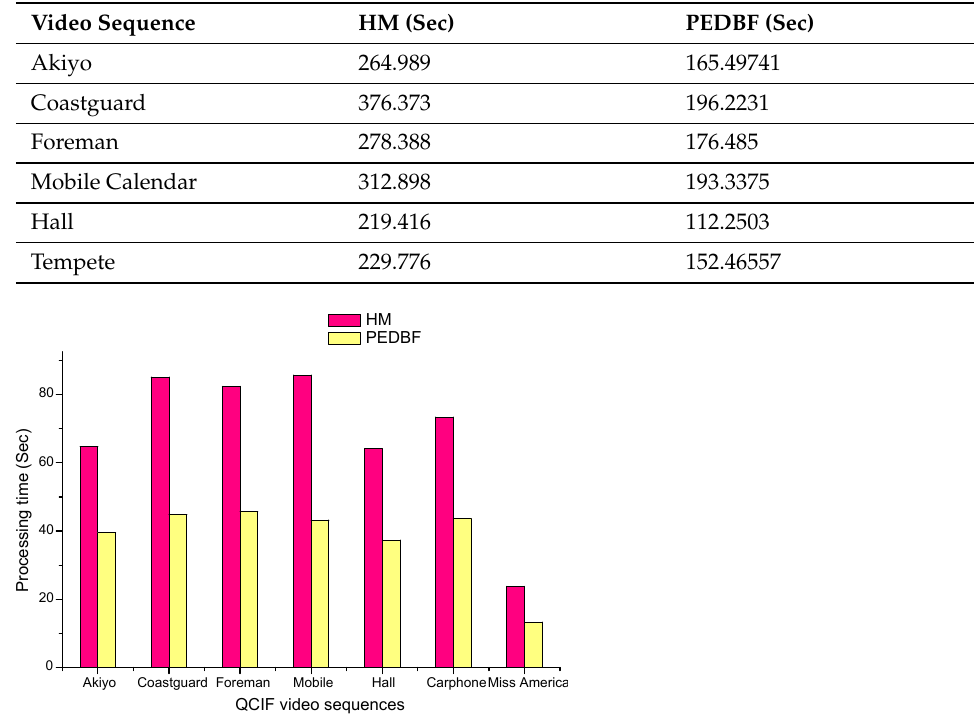
Table 4. Processing time of CIF video sequences with QP = 32.